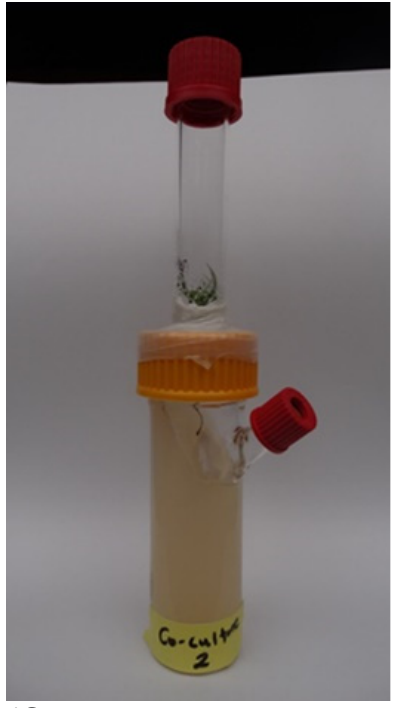
Figure 1. Experimental set up for the sampling of root volatile organic compounds. The green tree parts are visible and separated from the below-surface root fungus system, where sampling was made possible through the inlet Teflon cap visible at the right.